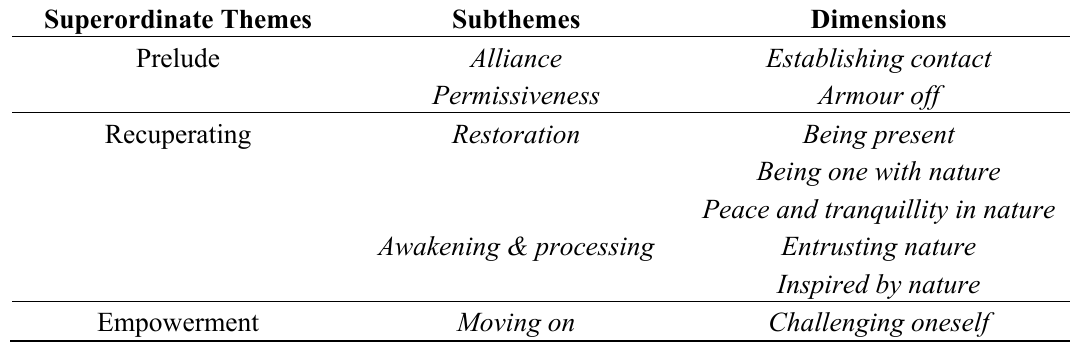
Table 1. Three superordinate themes emerged from the data: Prelude , Recuperating and Empowerment . The order of superordinate themes and subthemes is in the sequence with which the participants described the development of the process. The dimensions described are parts of an interwoven process within each phase rather than separate sequences like the